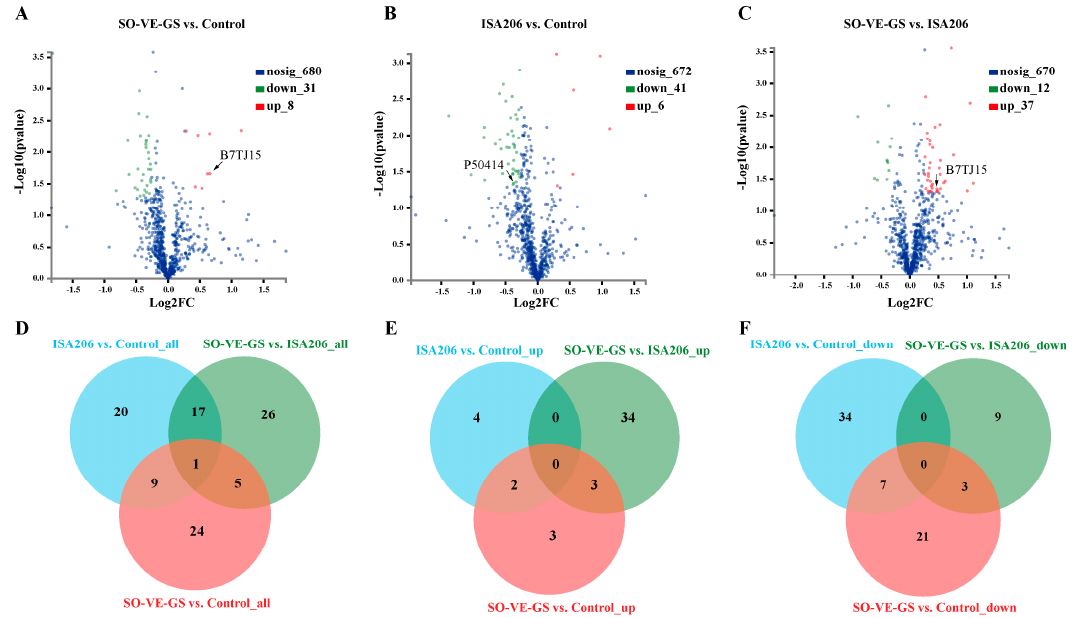
Figure 4. Differentially expressed proteins (DEPs) in three comparisons. Blood samples (n = 3) were collected at 8 weeks after immunization of Hu sheep with FMD vaccines adjuvanted with SO-VE-GS or ISA 206, and animals without immunization served as a control; sera were used for proteomic analysis. ( A – C ) Volcano plots of DEPs in three comparisons: SO-VE-GS vs. control, ISA 206 vs. control, and SO-VE-GS vs. ISA 206. MAPK14 (B7TJ15) and TGF- β 1 (P50414) were labeled. ( D – F ) Venn diagrams of differentially expressed proteins enriched by gene ontology (GO) analysis ( P < 0.05, fold change > 1.2 or < 0.83 = Log 2 FC > 0.26 or Log 2 FC < − 0.26).